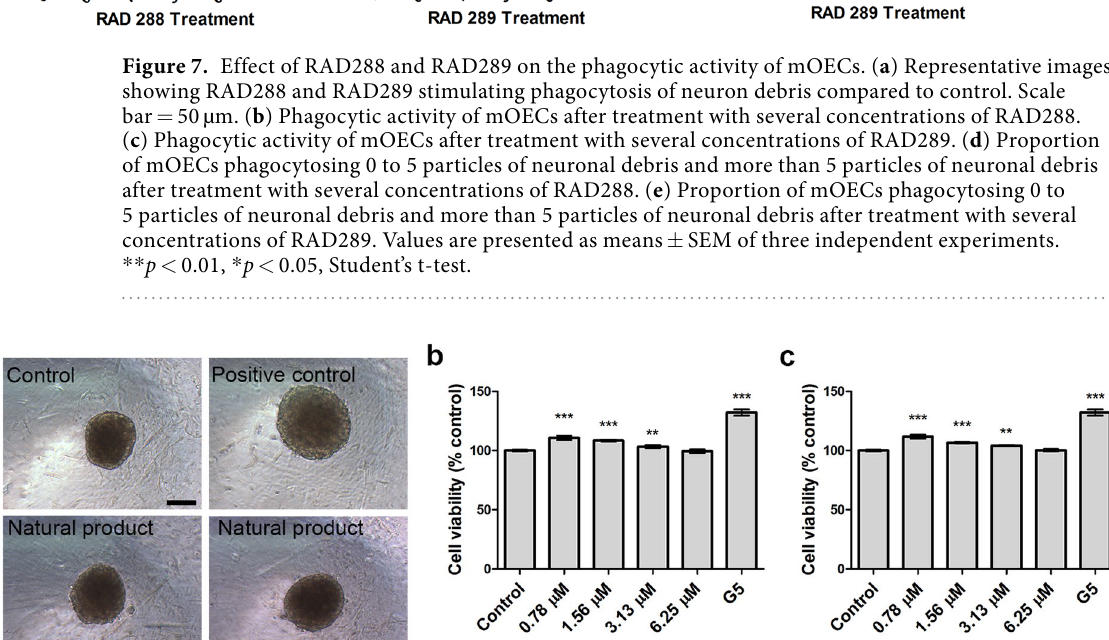
RAD289. Indeed, the viability of 3D mOECs increased by 11% (p < 0.001), 6% (p < 0.001) and 3% (p < 0.01) after exposure to RAD289 at 0.78, 1.56 and 3.13 µ M respectively (Fig. 8a,c). Treatment with G5 supplement induced a 30% (p < 0.001) increase in 3D mOEC spheroid viability.